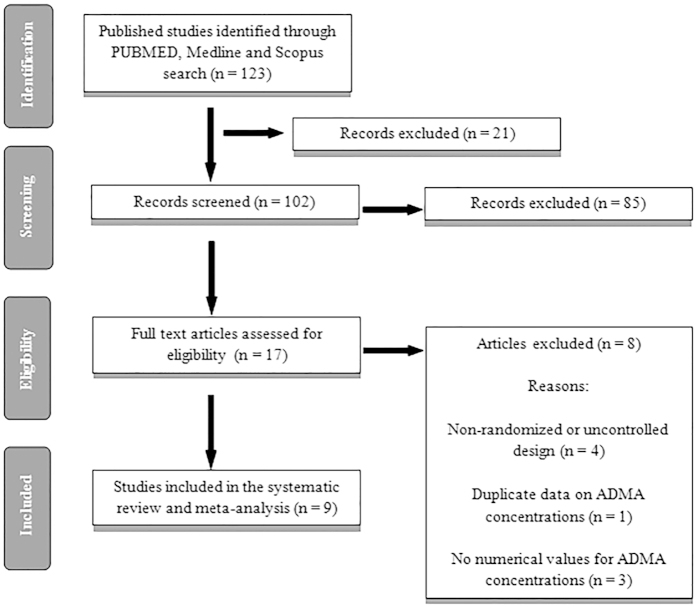
Flow chart of number of studies identified and included into the meta-analysis.